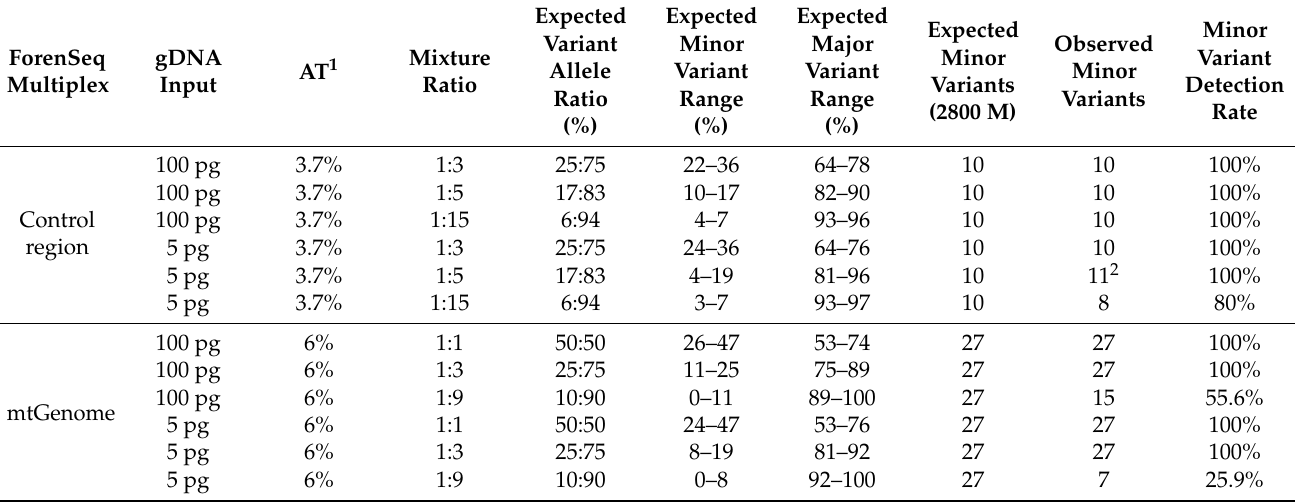
Table 3. Two-person (2800 M:HL60) mtDNA mixtures at different ratios and DNA inputs: ForenSeq control region and mtGenome